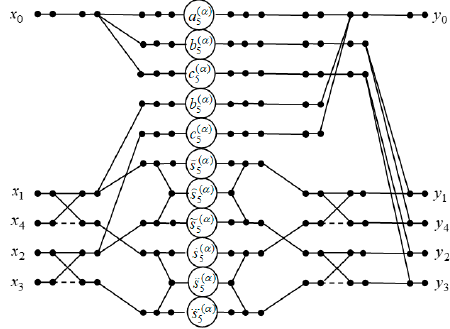
Figure 4. The data flow structure of the processing unit for computation of 5-point DFrFT.